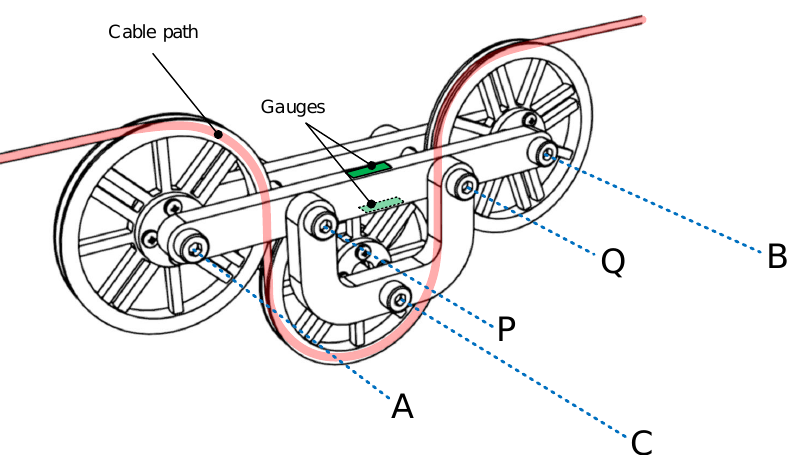
Figure 7. Strain gauges position for bending moment measurement. A,B,C = pulley centers, P,Q = connection points between bars 2 and 3.